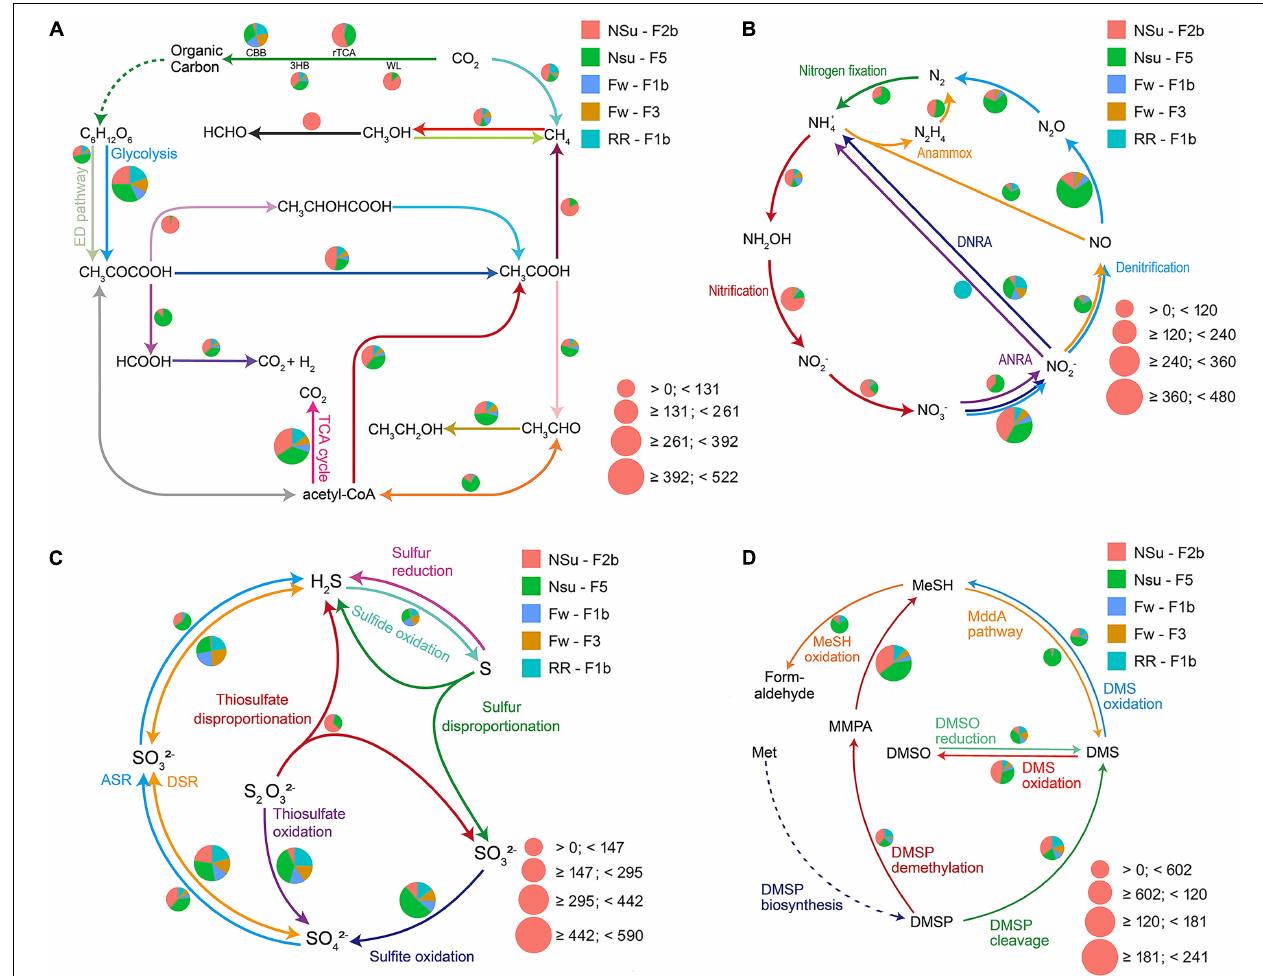
FIGURE 3 | Pie charts representing the relative abundance of carbon (A) , nitrogen (B) , sulfur (C) , and DMSP (D) cycle-related pathways for five metagenomic samples from the Manus Basin. Normalized relative abundance was calculated through dividing the relative abundance of a pathway in an individual sample by the sum of this pathway’s relative abundance in all samples. The pie chart area reflects the relative abundance of the process according to the scale shown in pink. The dashed line in panel (D) means the data was not shown. (A) CBB, Calvin-Benson-Bassham cycle; rTCA, reductive citric acid cycle; WL, Wood-Ljungdahl pathway; 3HB, 3-hydroxypropionate bicycle. (B) ANRA, assimilatory nitrate reduction to ammonia; DNRA, Dissimilatory nitrate reduction to ammonia; Anammox, anaerobic ammonia oxidation. (C) ASR, assimilatory sulfate reduction; DSR, dissimilatory sulfate reduction. (D) DMSP, dimethylsulfoniopropionate; MMPA, methylmecaptopropionate; MeSH, methanethiol; DMSO, dimethyl sulfoxide; L -Met, L -methionine. This figure was the output from